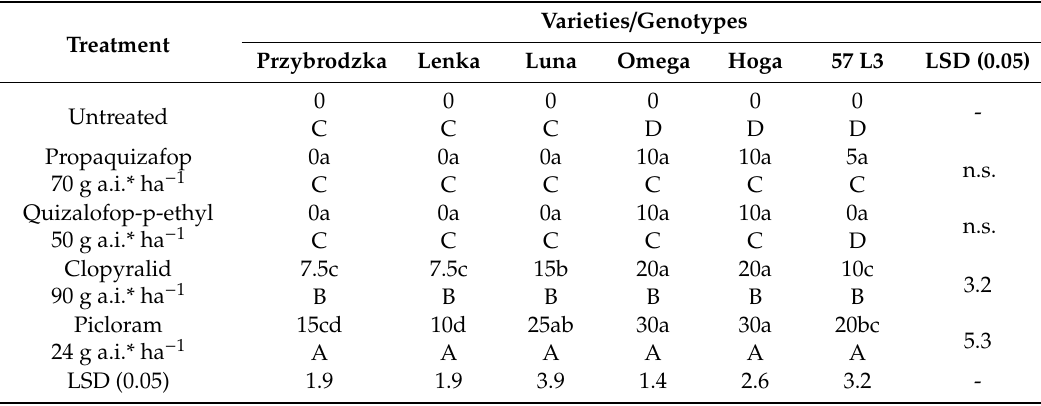
Table 2. Visual assessment of phytotoxicity (%) 42 days after treatment (42